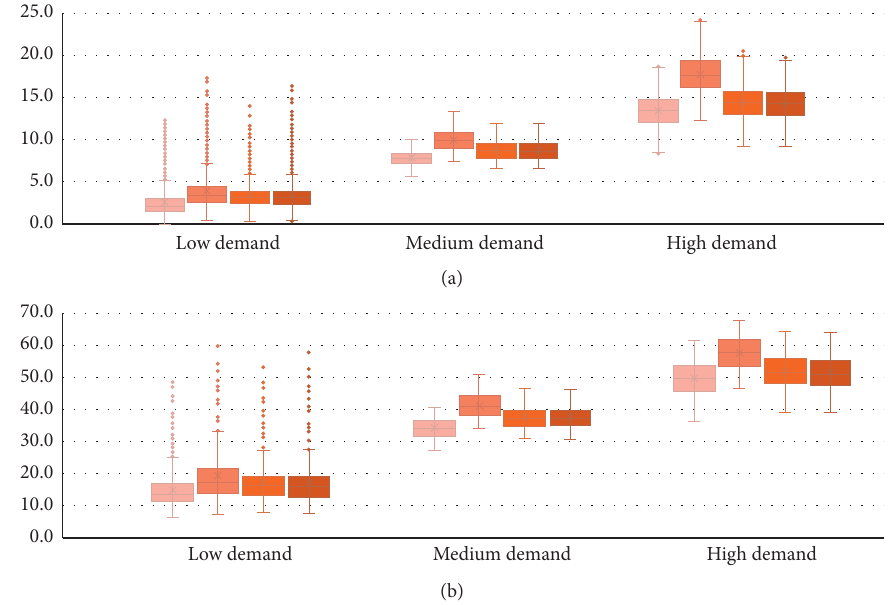
Figure 5: Box plots for traffic parameters controlled by different strategies under different demand levels. (a) Box plots for average intersection queue length. (b) Box plots for average intersection waiting